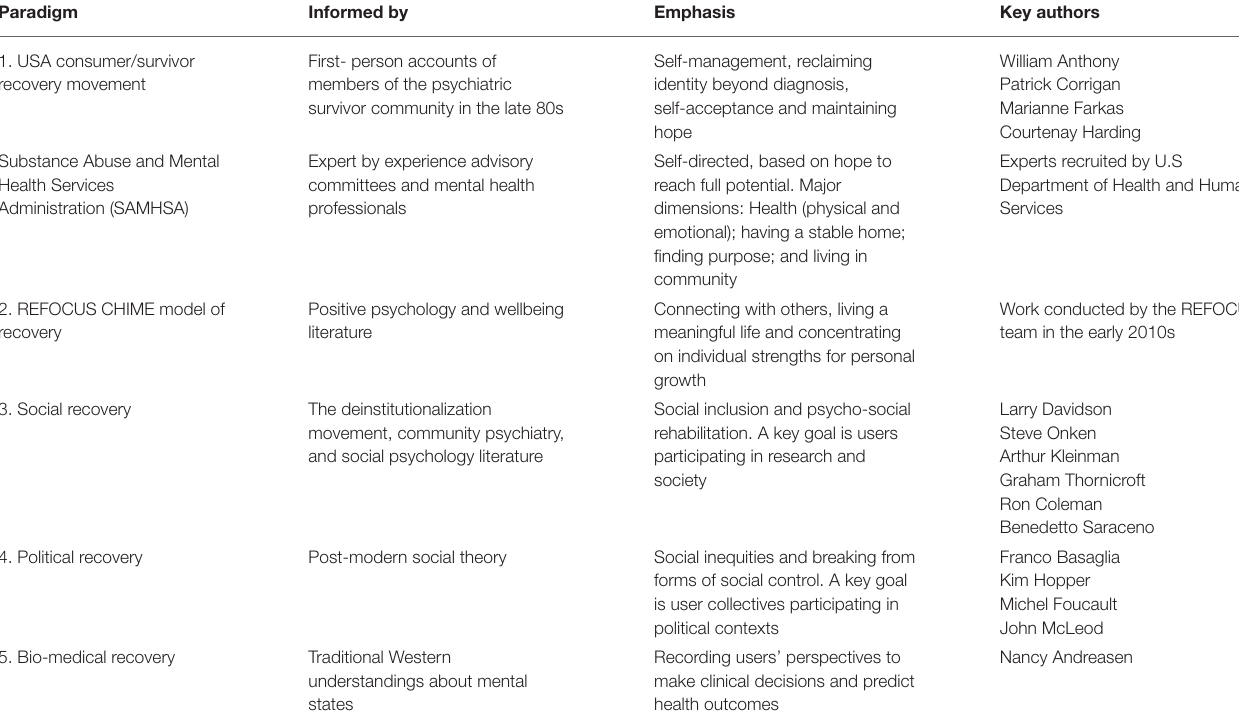
TABLE 1 | Description of recovery paradigms identified in the literature.